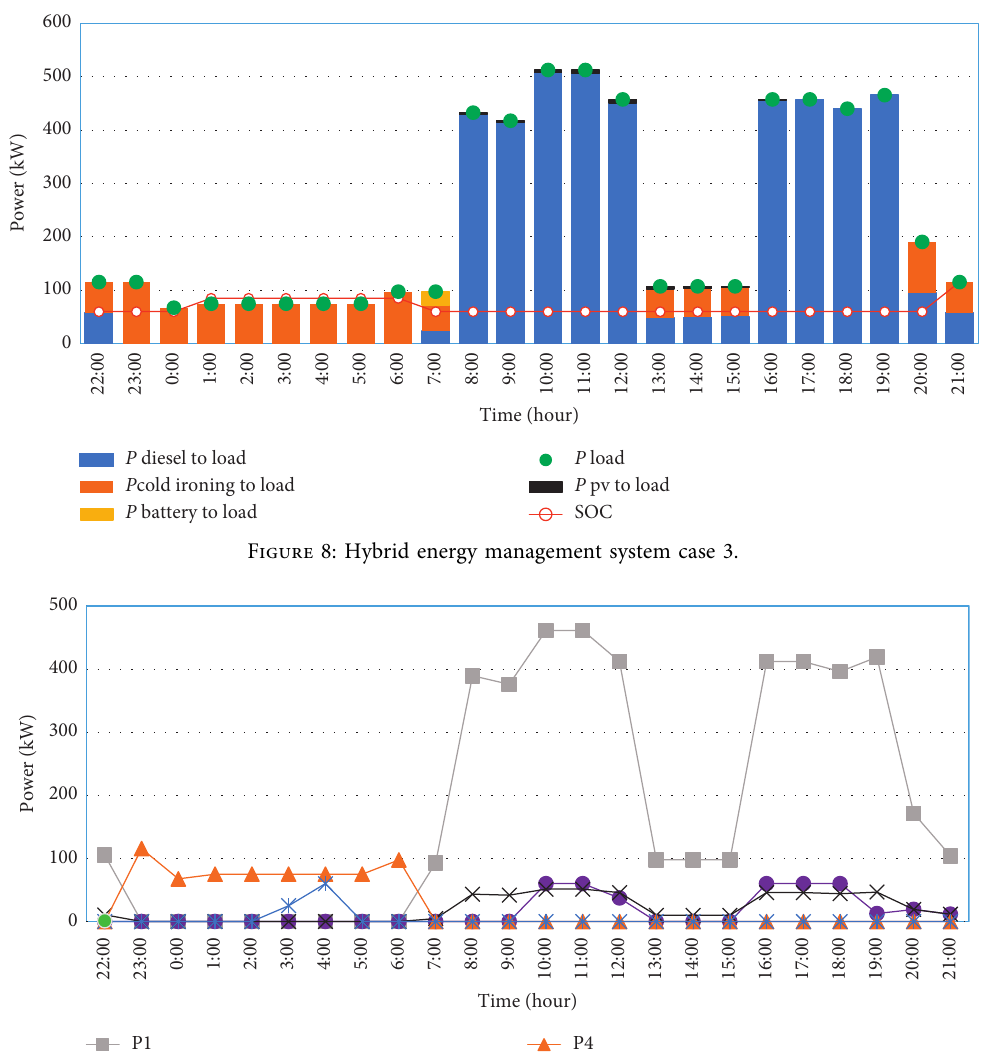
Figure 7: Hybrid energy management system case